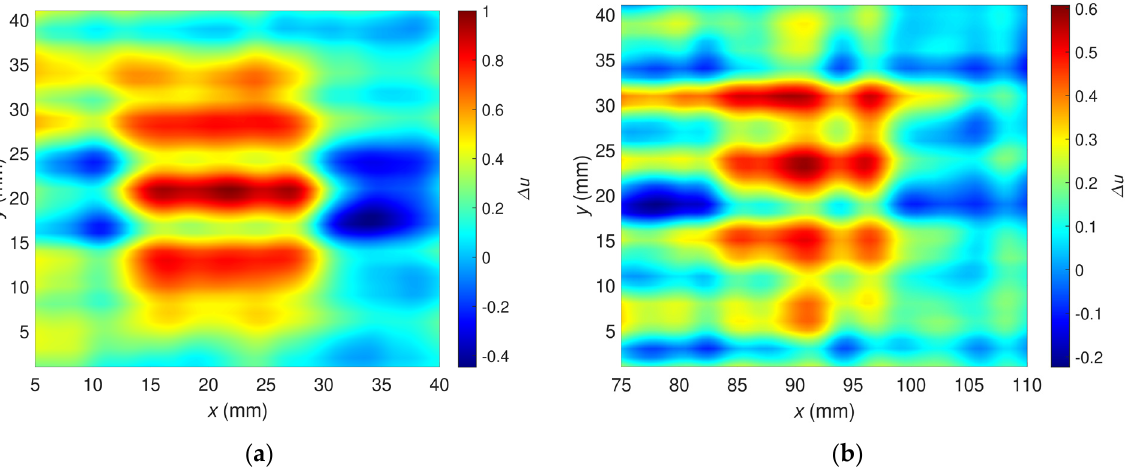
Figure 9. Two-dimensional plot of the relative voltage as a function of the sensor position; excita- tion frequency f = 2 MHz; a raw signal before background removal.